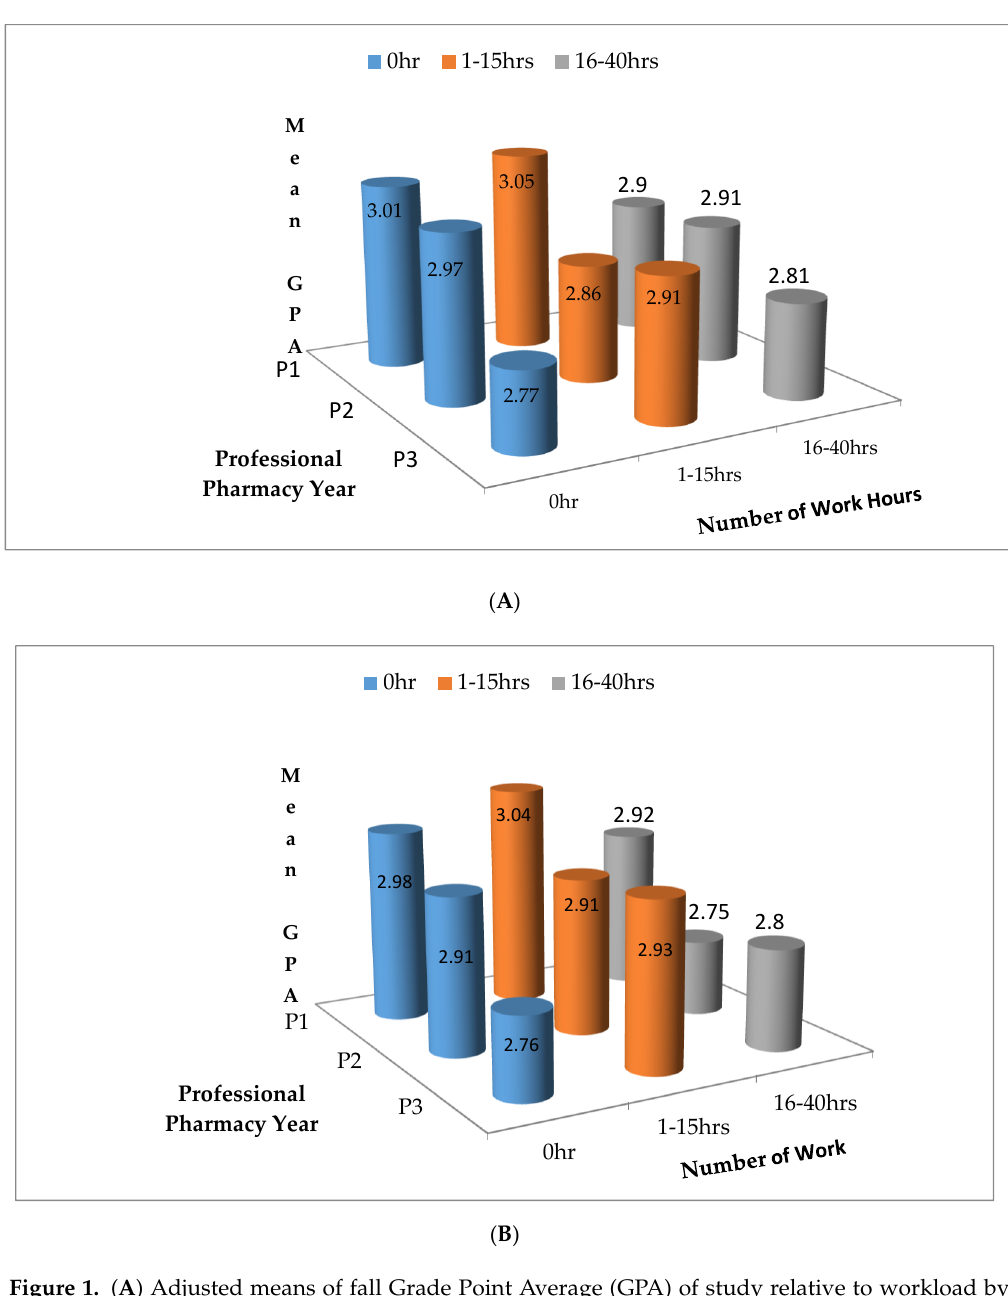
Figure 1. ( A ) Adjusted means of fall Grade Point Average (GPA) of study relative to workload by professional pharmacy year. ( B ) Adjusted means of spring GPA of study relative to workload by professional pharmacy year. hrs = hours. Table 3. Association of workload with academic performance (grade point average).